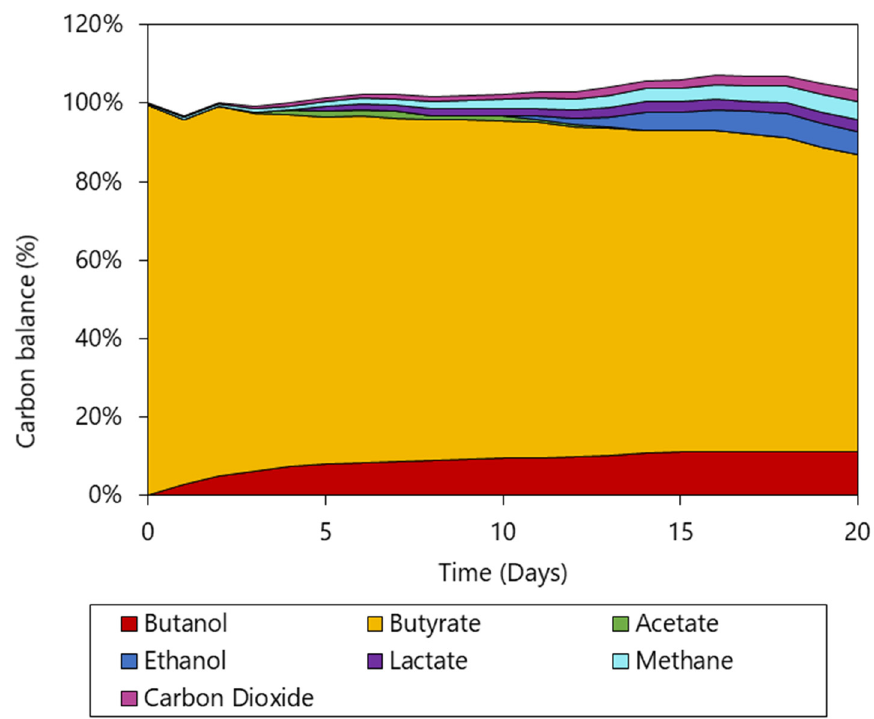
Figure 6. Carbon balance during the course of the bioreactor experiment. By-products include acetate, ethanol, lactate, and methane.